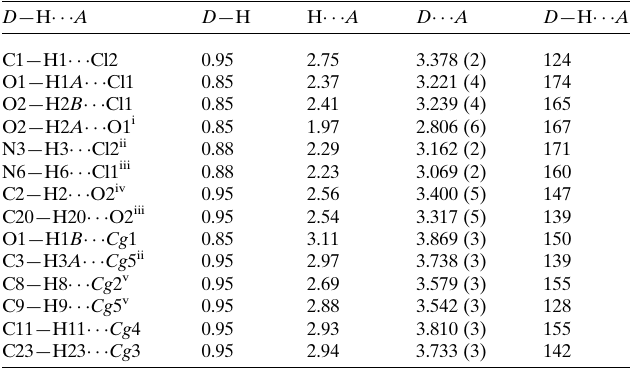
Table 1 Hydrogen-bond geometry (A˚ , (cid:4) ). Cg 1, Cg 2, Cg 3, Cg 4 and Cg 5 are the centroids of the C7–C12, N5/N6/C18/C19/ C24, N1/C1–C5, N4/C13–C17 and C19–C24 rings, respectively.